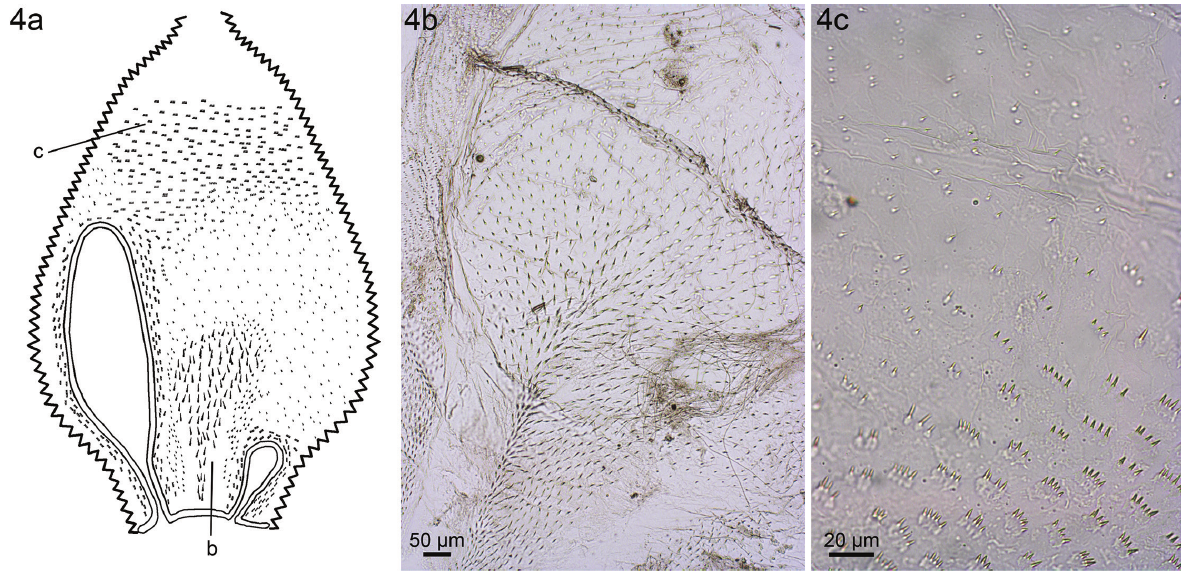
Figure 4. Cornitermes cumulans . (a) Schematic drawing of P1 showing arrangement of spines. (b, c) Photomicrographs: (b) Acicu- liform spines, situated between the mesenteric tongues; (c) Detail of short spines in rows, present around the mesenteric tongues and next to